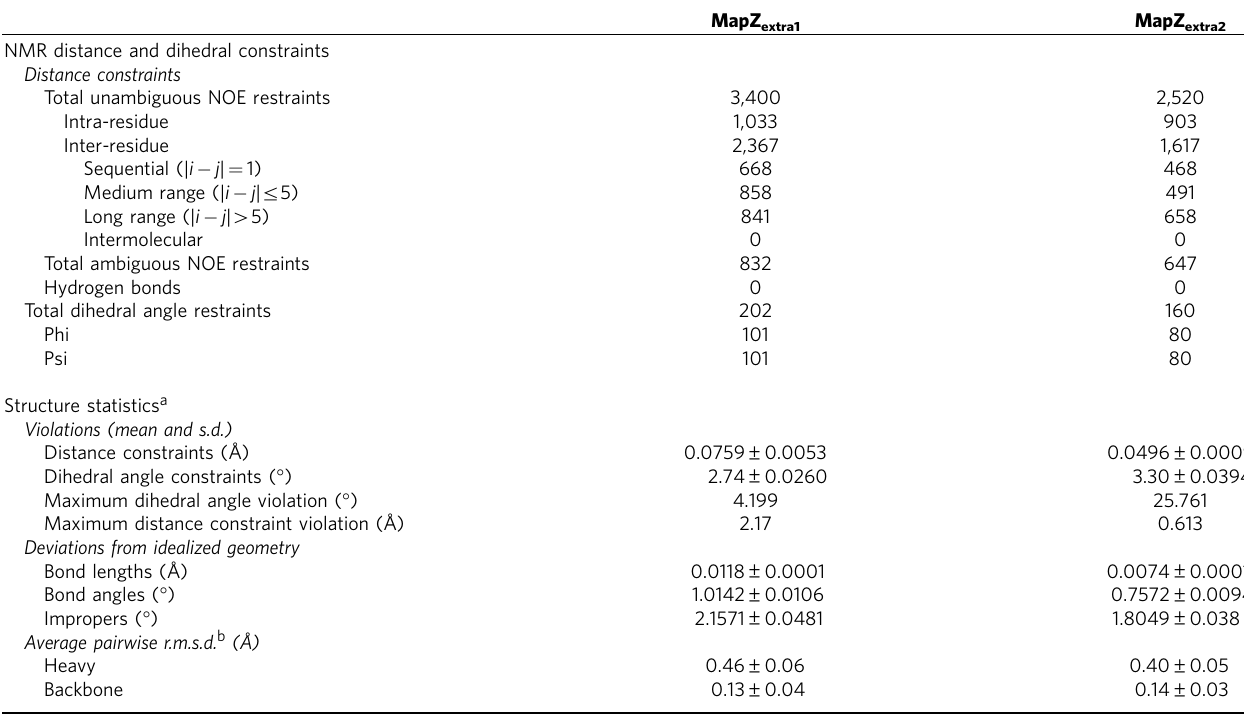
Table 1 | Structural statistics for the ensemble of 20 NMR structures of MapZ extra1 (PDB code 2ND9) and MapZ extra2 (PDB code